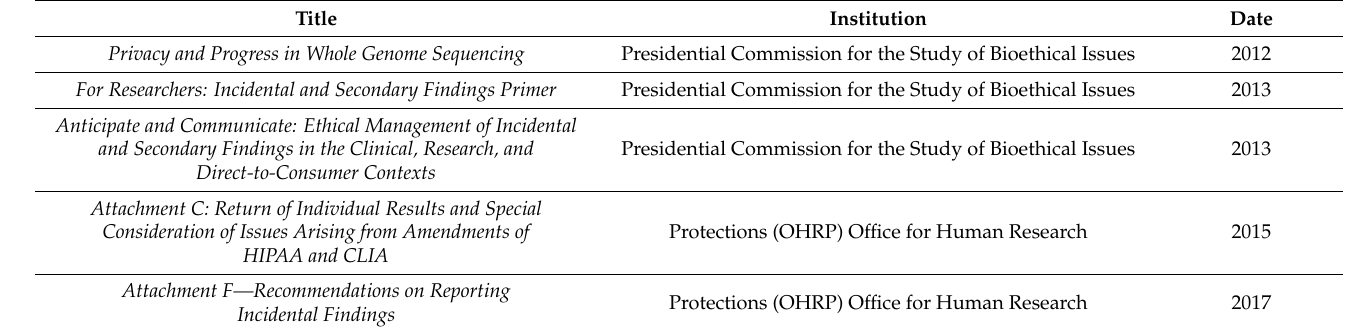
Table 1. Recommendations, Laws, and Acts around returning Incidental Findings in